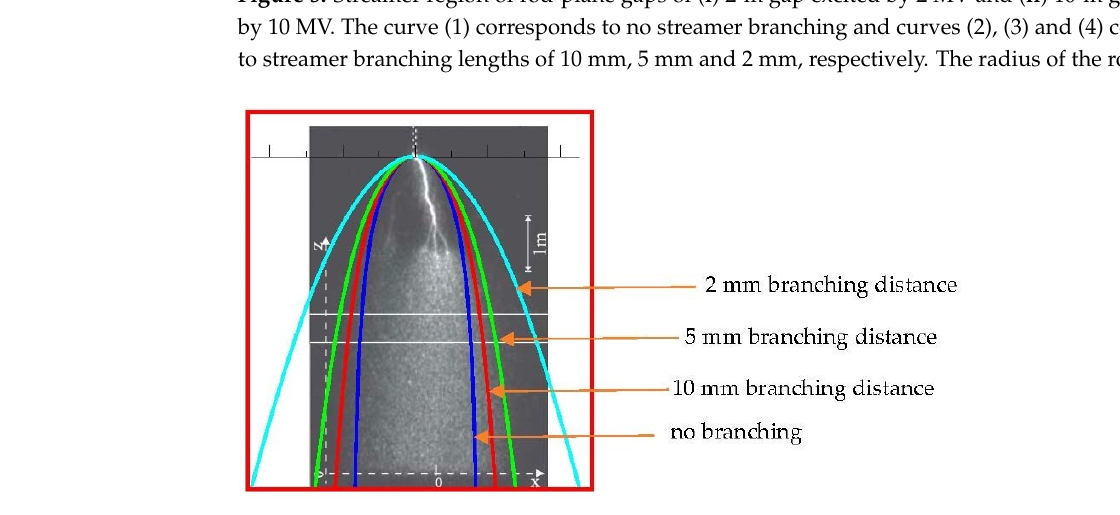
Figure 6. A photograph of the streamer zone of a 5.5-m rod-plane gap with an applied voltage of 5 MV as published by Bogatov et al. [10]. The four curves shown in the diagram correspond to the following cases. Blue: No branching; red: 10 mm branching distance, green: 5 mm branching distance and turquoise: 2 mm branching distance.